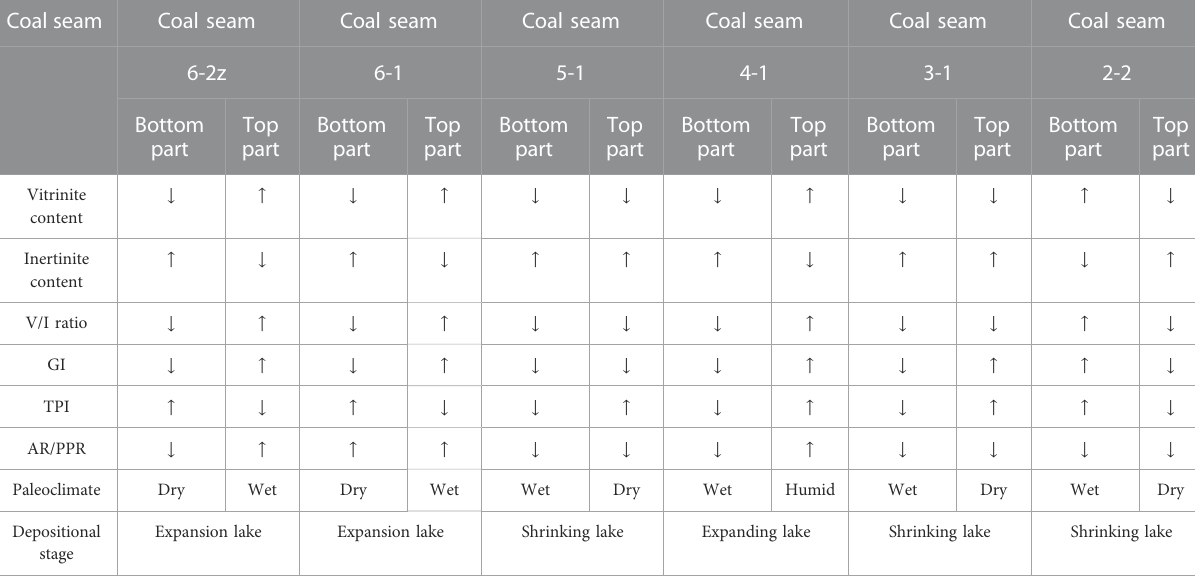
TABLE 4 Tendency (increasing or decreasing) of the maceral characteristics in the coal seams under study. Coal